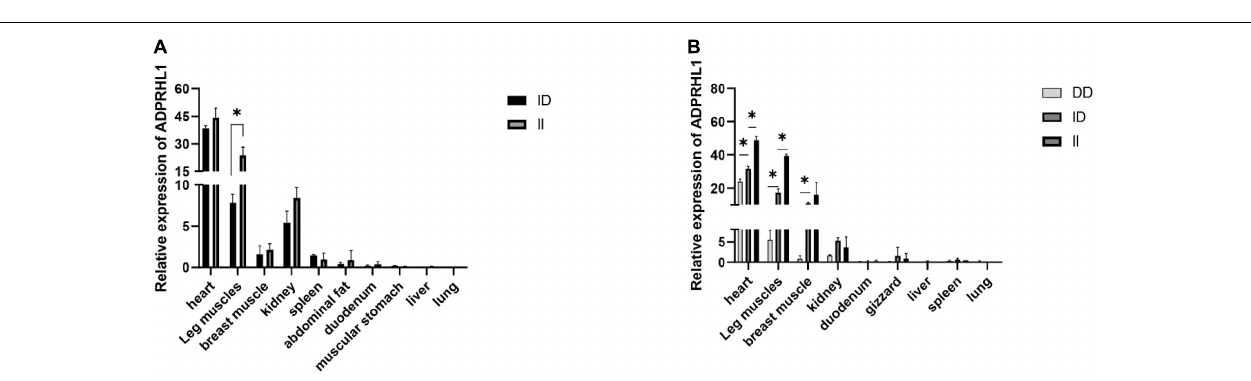
FIGURE 5 | Relative expression patterns of ADPRHL1 . (A) Expression patterns of different genotypes of ADPRHL1 in Arbor Acres broiler at 1 week of age. ID, n = 3; DD, n = 5. (B) Expression patterns of different genotypes of ADPRHL1 in Lushi chicken at 3 weeks of age. DD, n = 3; ID, n = 3; DD, n = 3. Error bars represent the SEM. ∗ P <